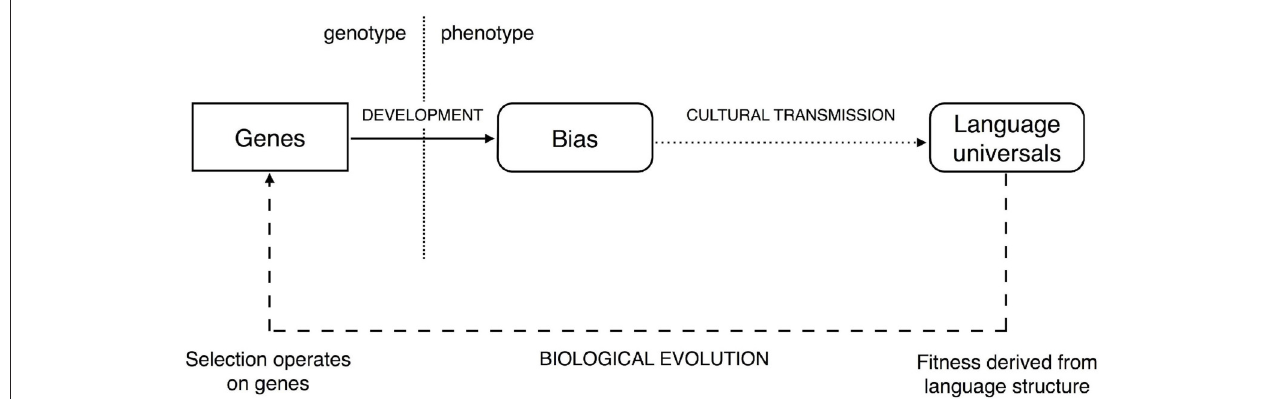
FIGURE 1 | The link between genes and the universal properties of language is mediated by development and cultural transmission. The extent to which these two processes have non-trivial dynamics is an important consideration when proposing evolutionary accounts of language. Fitness does not depend directly on the genes underpinning the language faculty, but rather the linguistic phenotype (i.e., languages). This opens up the possibility for development and cultural transmission to shield genetic variation from the view of natural selection (Figure adapted from Kirby et al., 2007). © 2007 by The National Academy of Sciences of the